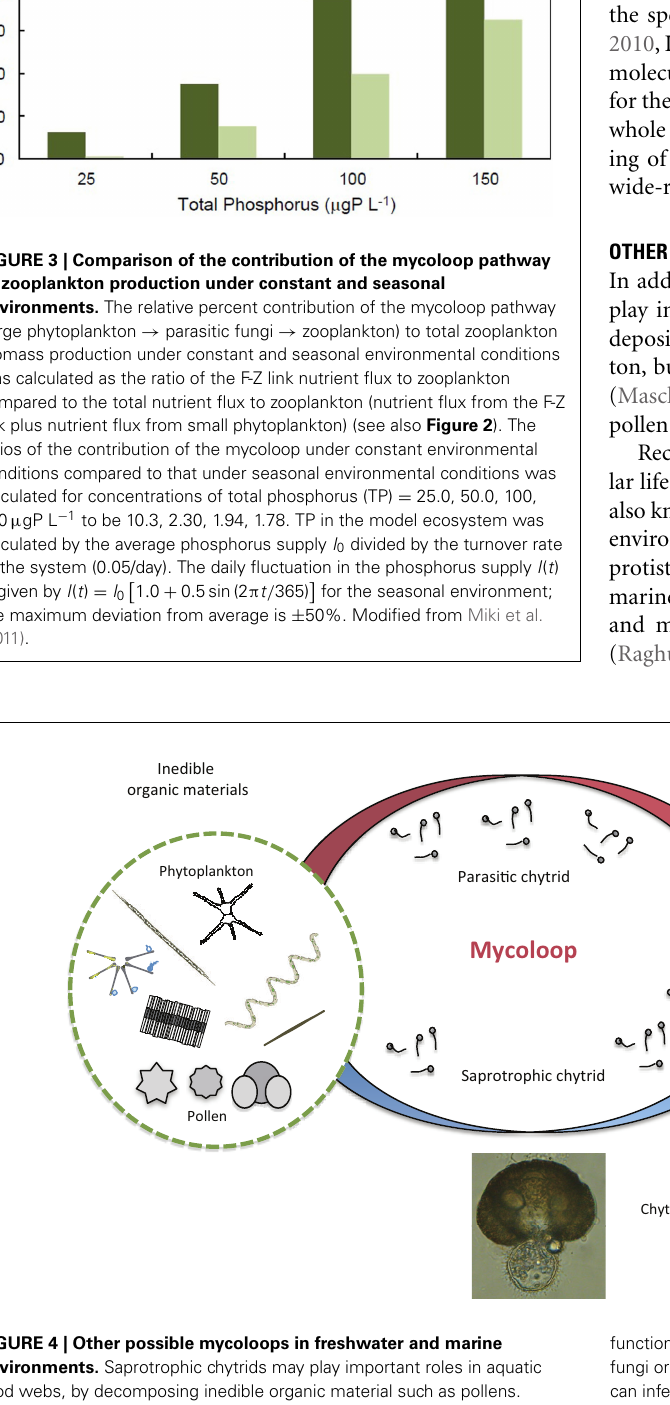
FIGURE 4 | Other possible mycoloops in freshwater and marine environments. Saprotrophic chytrids may play important roles in aquatic food webs, by decomposing inedible organic material such as pollens. Zoospores released from pollen may be consumed by zooplankton,